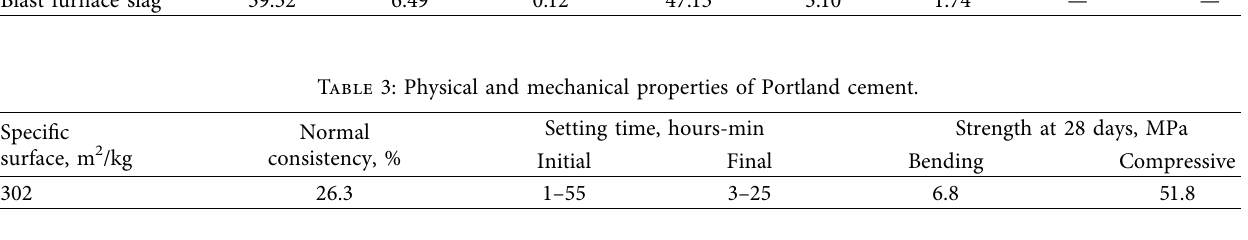
Table 4: Planning matrix and properties of concrete mixtures at experimental points. No.